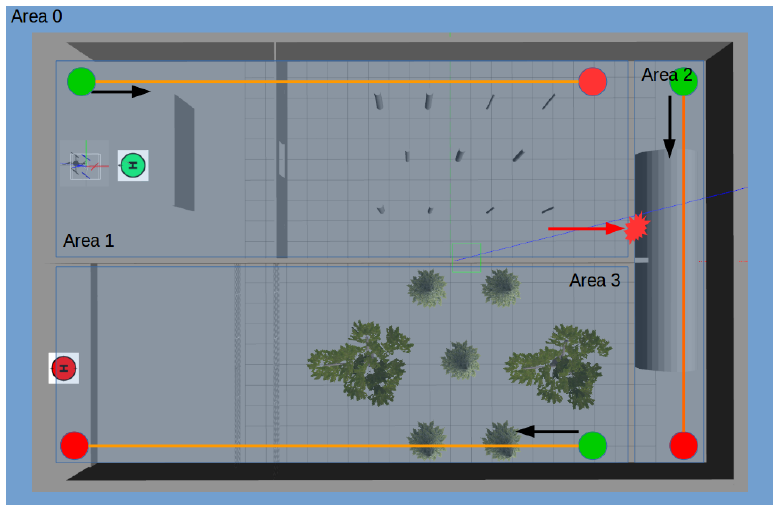
Figure 9. This diagram shows the top view of the environment and the sections of the environment used for generating reward and resetting the UAV.